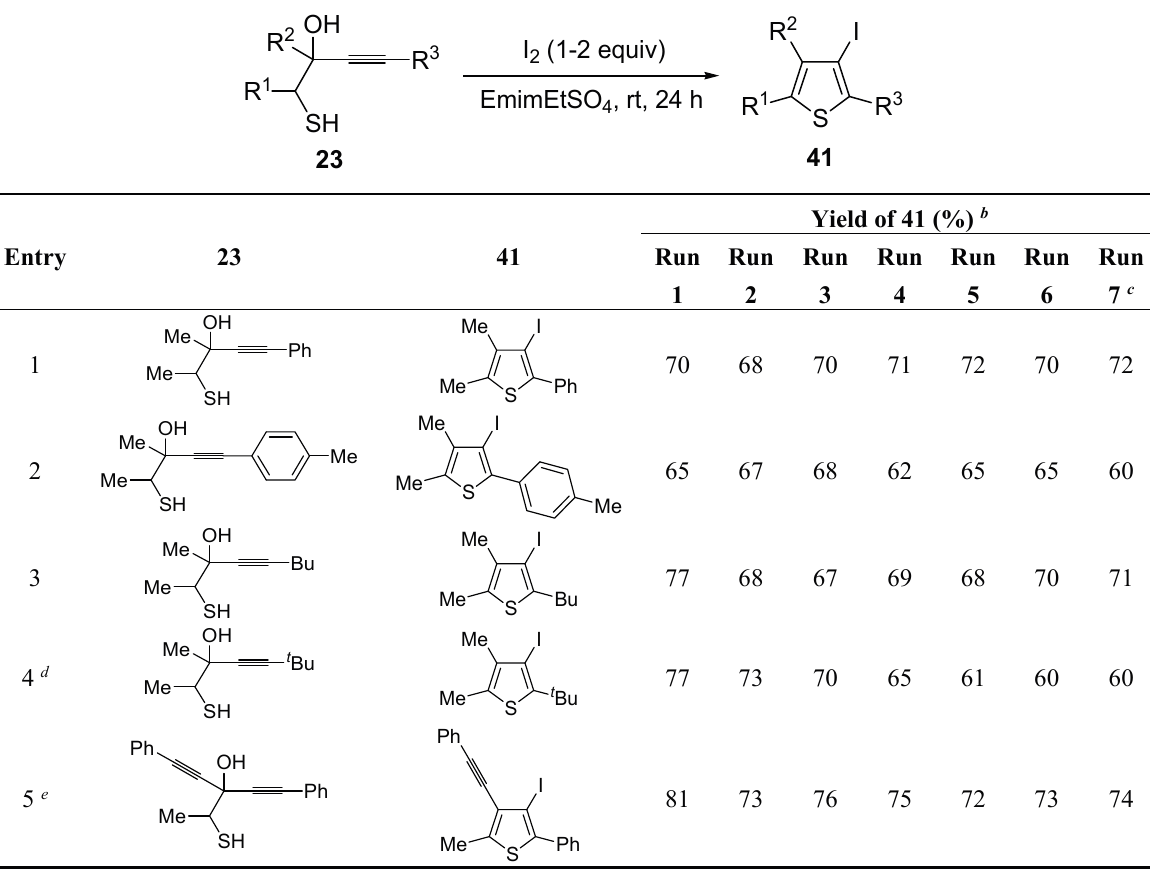
Table 5. Recyclable and base-free synthesis of 3-iodothiophenes 41 by iodoheterocyclization of 1-mercapto-3-yn-2-ols 23 in EmimEtSO 4 a